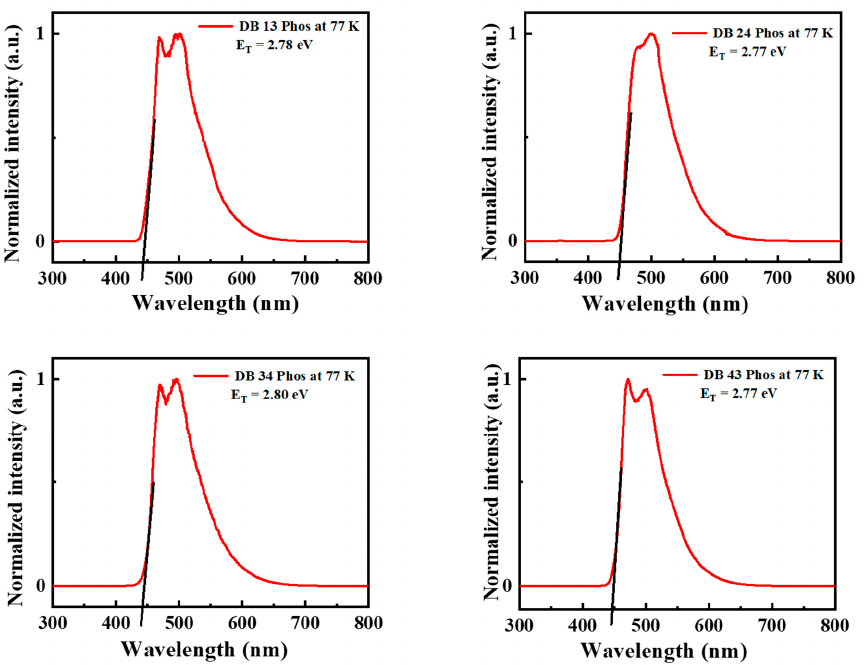
Figure 6. Low–temperature photoluminescence (LTPL) spectra at 77 K of the compounds DB13, DB24, DB34 and DB43.